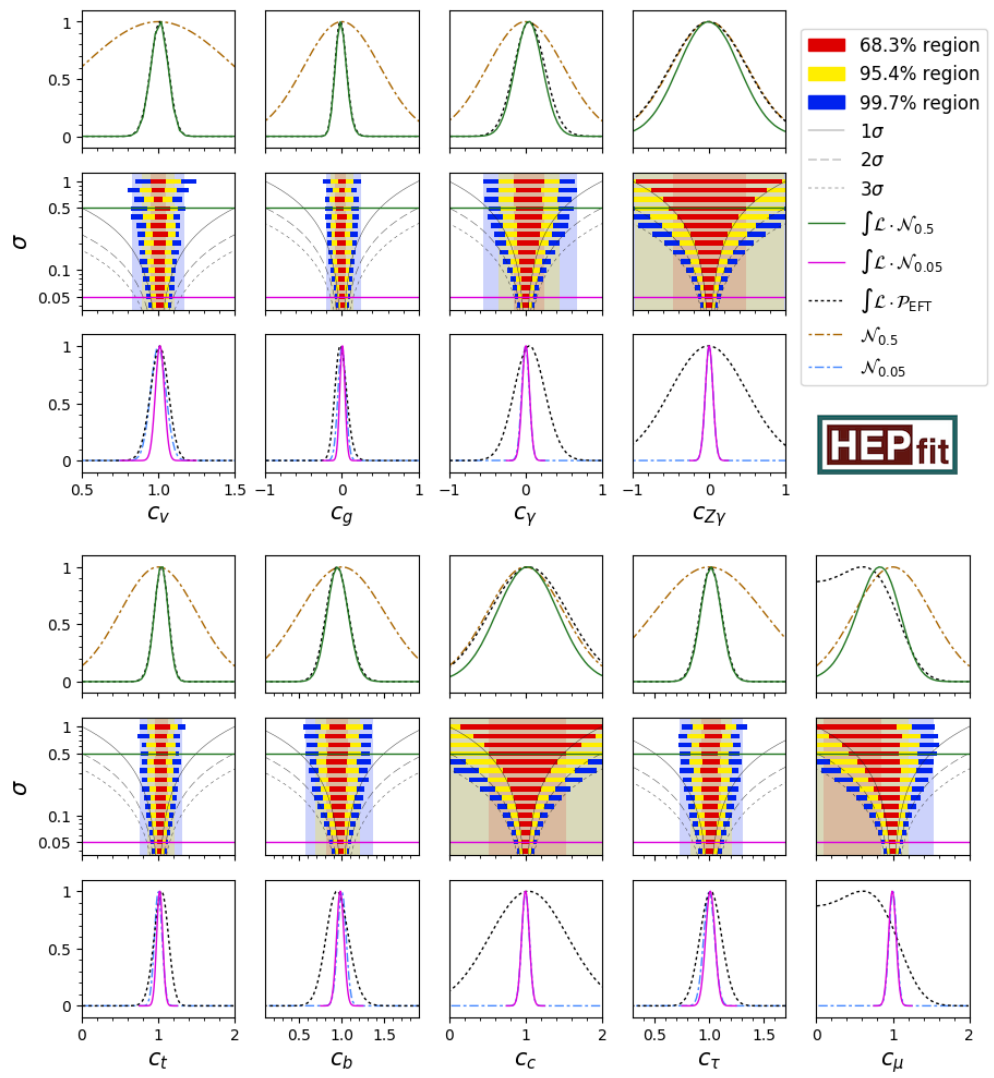
Figure 4 . Scan of the posterior for di(cid:11)erent universal widths of the Gaussian prior, inspired by [63]. For each coupling, we show how the posterior evolves with increasing width of the Gaussian priors in the central panel. The 68.3%, 95.4% and 99.7% probability regions are red, yellow and blue bars, respectively; the transparent bands in the background represent the (cid:12)t with the priors P EFT . The upper (lower) panel of each coupling shows the N 0 : 5 ( N 0 : 05 ) prior in brown (light blue), its posterior in green (pink) and the P EFT posterior as the dotted black